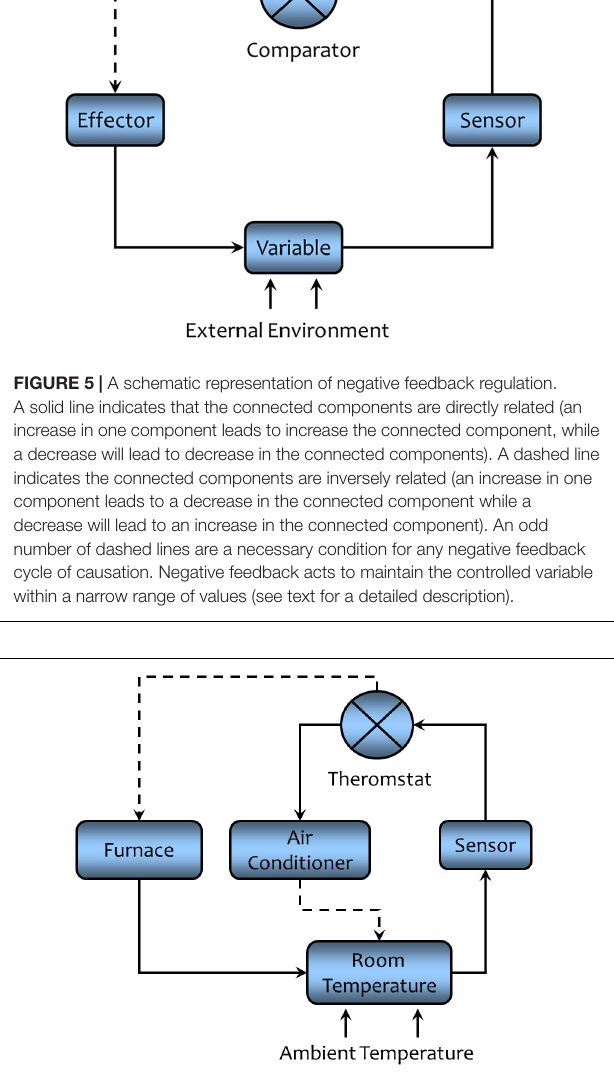
FIGURE 6 | A schematic representation of the regulation of room temperature to illustrate the concept of negative feedback regulation. A solid line indicates that the connected components are directly related (an increase in one component leads to an increase the connected components, while a decrease will lead to a decrease in the connected components). A dashed line indicates that the connected components are inversely related (an increase in one component leads to a decrease in the connected component while a decrease will lead to an increase in the connected component). Negative feedback acts to maintain the room temperature within a narrow range of values despite changes in ambient temperature (see text for a detailed